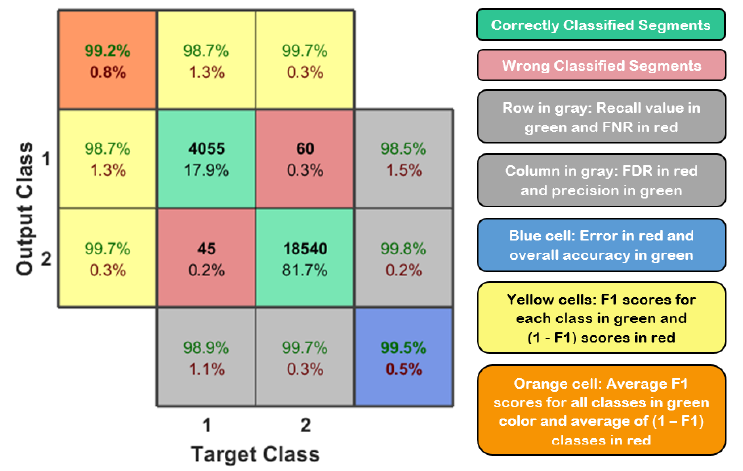
Figure 11. Typical confusion matrix for binary classification on the left side and the representation of these values based on their background colors on the right side